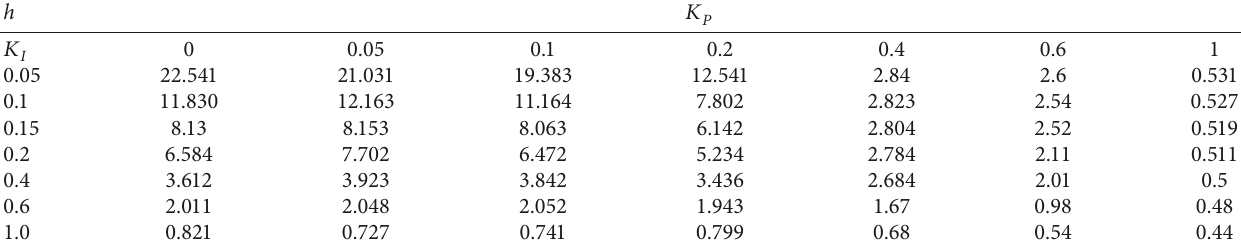
,K ) for single-area LFC with μ � 0 . 9 , ρ � 0 . 025 , τ � 0 . 025. P I